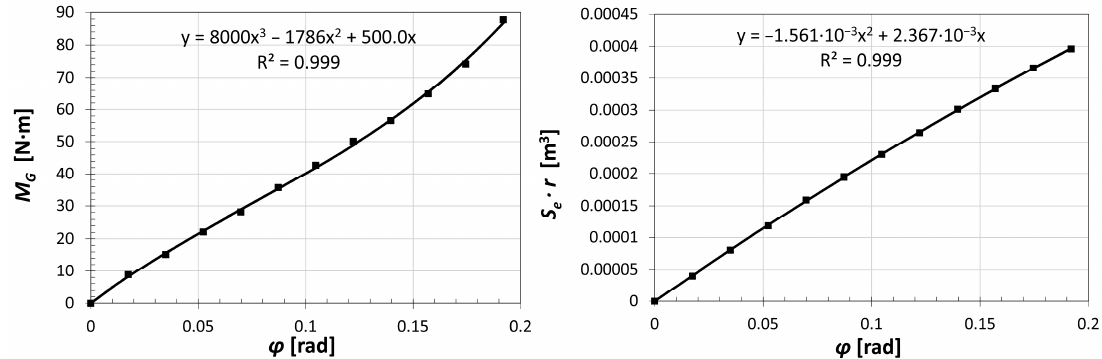
Figure 3. Static parameters of 4–2 / 70–T–C -type pneumatic tuner of torsional oscillations: ( a ) rubber shell torque; ( b ) e ff ective area of the coupling compression